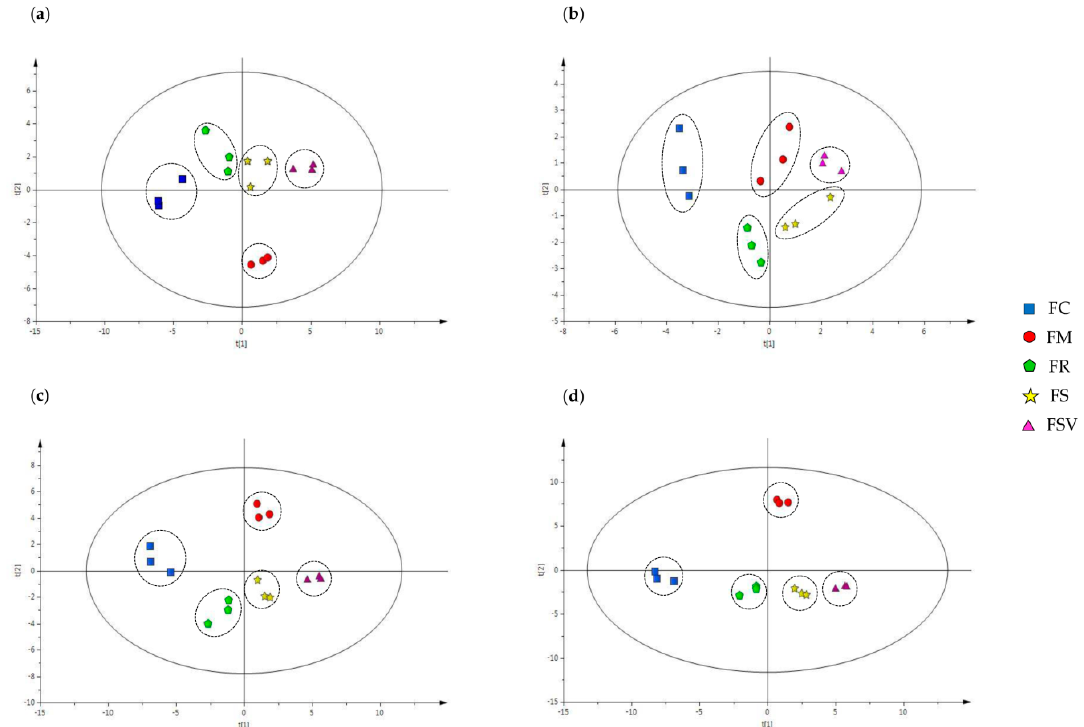
Figure 7. Orthogonal Projections to Latent Structures-Discriminant Analysis (OPLS-DA) multivariate statistical analysis of four Fraxinus species and variety: ( a ) anatomical data of leaves; ( b ) anatomical data of stem bark; ( c ) anatomical data of the leaves combined with anatomical data of stem bark; ( d ) anatomical data of leaf and bark combined with HPLC quantification data. FC, Fraxinus chiisanensis ; FM, F. mandshurica ; FR, F. rhynchophylla ; FS, F. sieboldiana ; FSV, F. sieboldiana var. angustata .